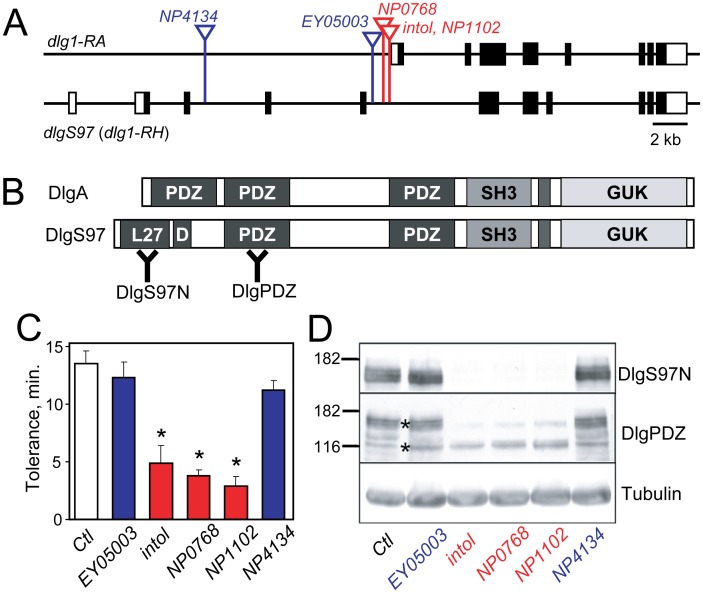
Genomic structure, additional mutants and protein products of the dlg1 locus.(A) Schematic representation of dlg1 genomic structure for two major characterized transcripts, dlg1-RA and dlg1-RH. Exons are represented with boxes, protein-coding sequences by filled boxes, and introns by lines. Vertical lines with inverted triangles denote independent P-element insertions in dlg1 including intol. (B) Schematic depiction of DlgA (dlg1-RA product) and DlgS97 (dlg1-RH product) showing characterized protein domains. Two distinct regions used for generating antibodies are indicated as “Y” in bold. (C) Two additional transposon mutants in dlg1, NP0768 and NP1102, whose positions are shown in red in panel (A), also showed reduced ethanol tolerance (***, [F(5,18) = 19.973, p<0.001], one way ANOVA followed by Holm-Sidak test, n = 4). (D) The same subset of dlg1 mutants showed loss of DlgS97. Immunoblot analysis was performed on protein from adult heads from control flies and the dlg1 mutants EY05003, intol, NP0768, NP1102, and NP4314 using pan-Dlg (“DlgPDZ”) and DlgS97-specific antibodies; tubulin was used as a loading control.